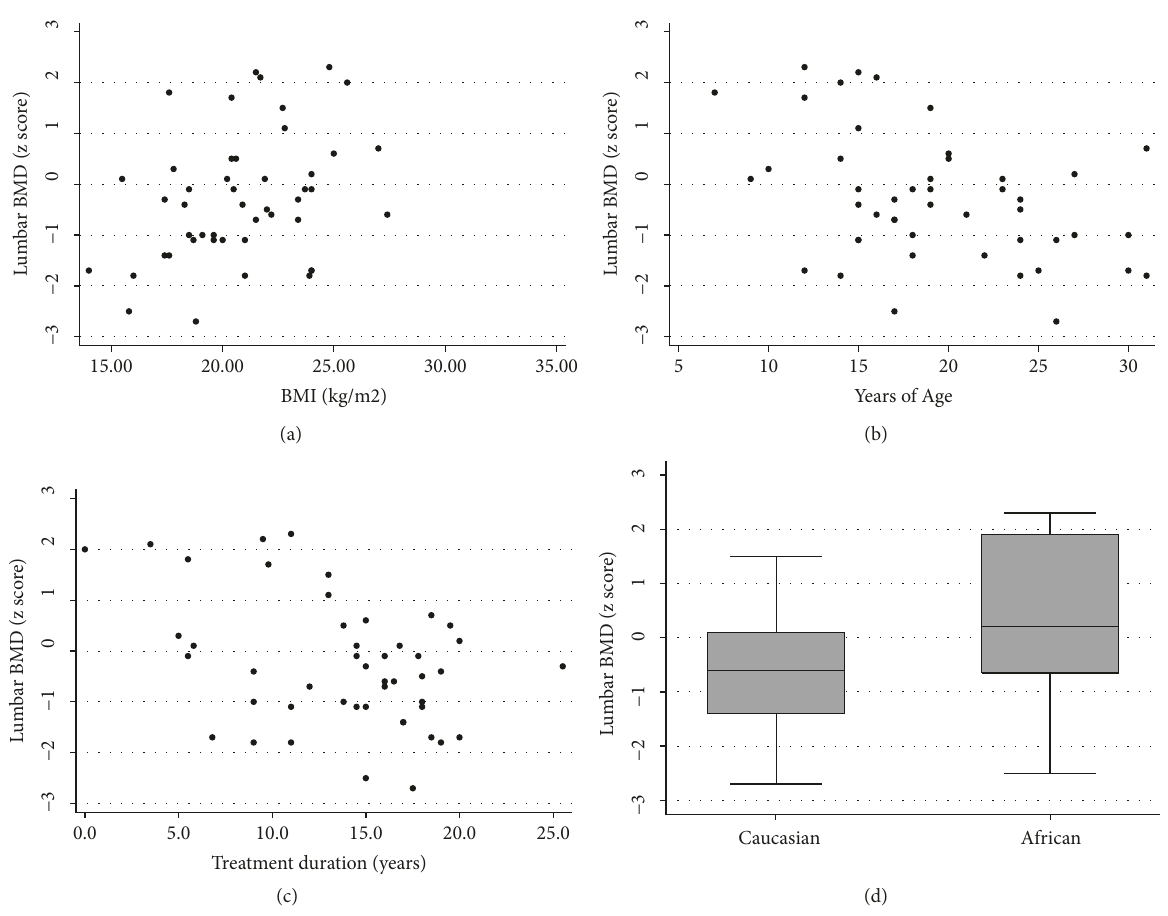
Figure 1: Scatterplots used to investigatethe relationship between lumbar BMD z-score and BMI (a), years of age (b), and treatmentduration (c). Box and whisker plot to investigate the relationship between lumbar BMD z-score and race.